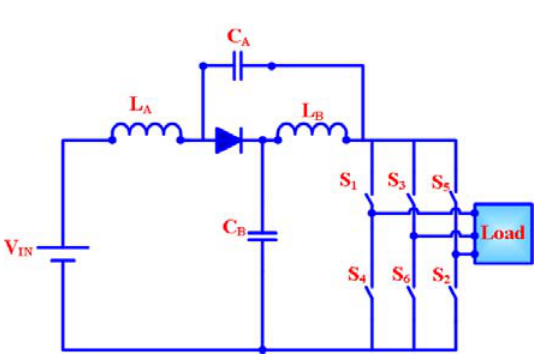
Figure 7. Equivalent power circuit of Quasi Z-source inverter. Energies 2018 , 11 , x